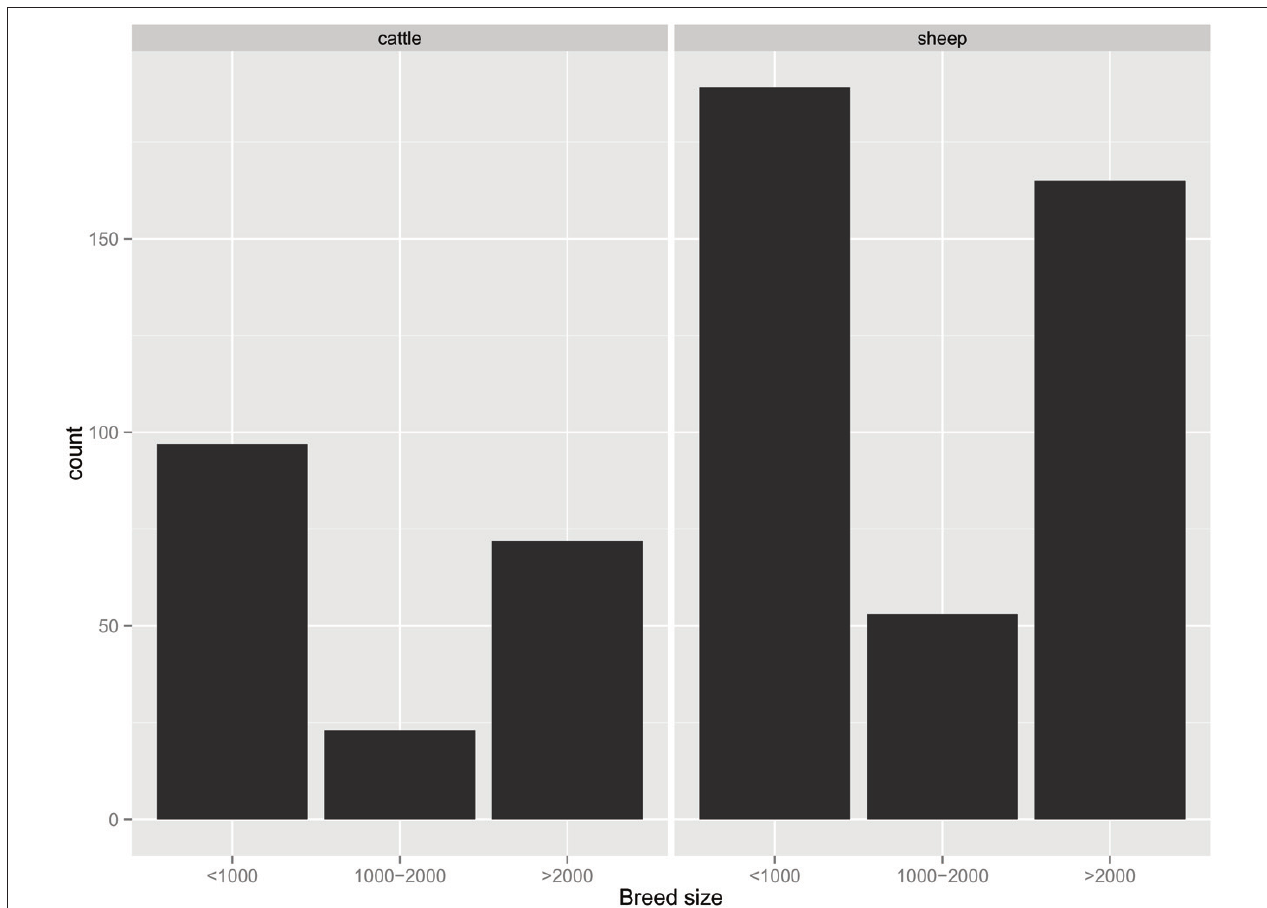
FIGURE 1 | Distribution of world cattle and sheep breeds according to the number of breeding females (data source DAD-IS: www.dad.fao.org, accessed on January 13, 2015): < 1,000, 1,000–2,000, >